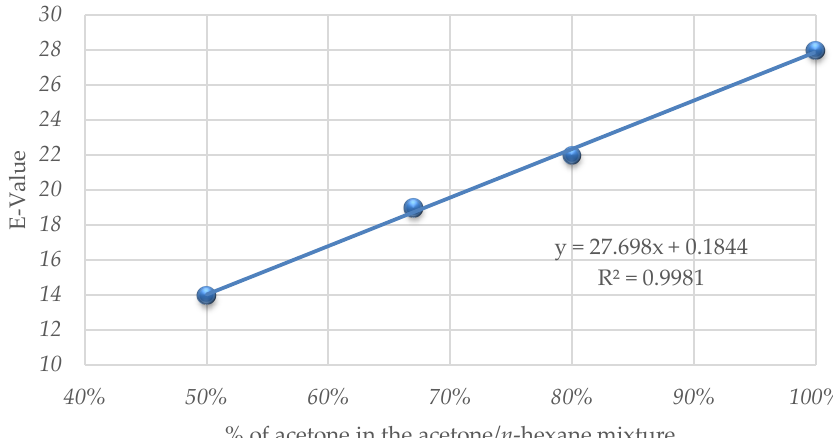
Figure 3. E-value versus acetone / n -hexane ratio of CAL-A-catalyzed irreversible transesterification of rac - 4 .